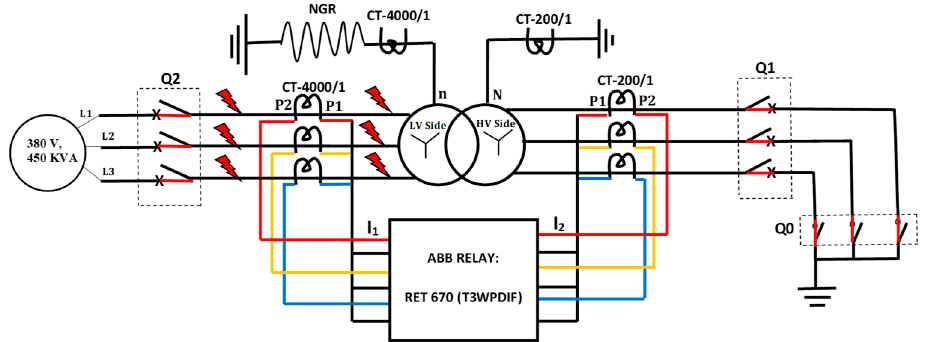
Figure 1. Proposed connection diagram for differential protection (87T). The transformer vector group is YNyn0, with its HV side solidly grounded, and its LV side is grounded through a neutral grounding resistor (NGR). The HV and LV CTs have 200/1 and 4000/1 ratios, respectively. The HV and LV sides’ neutral CT ratios are 200/1 and 4000/1, respectively. Q 0 is an earth switch, Q 1 is a primary side circuit breaker, and Q 2 is a secondary side switchgear circuit breaker. The power transformer technical details are mentioned in Table